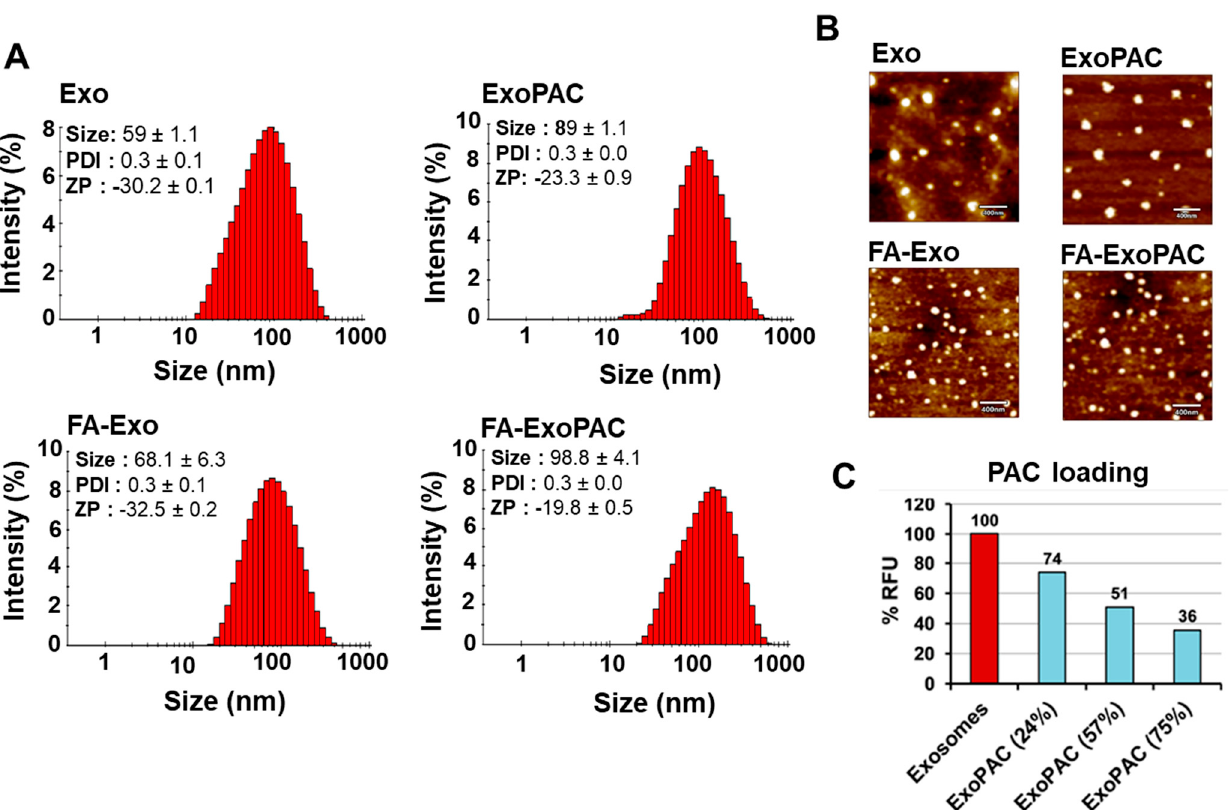
Figure 1. Characterization and drug loading of colostrum-derived exosomes. Size, polydispersity index (PDI), and zeta potential (ZP) of exosomes, FA-Exo, ExoPAC and FA-ExoPAC, analyzed by Zetasizer. Data represent mean ± SD from three preparations ( A ). Analysis of exosomes and ExoPAC by atomic force microscopy (AFM) after diluting with deionized water up to 10 µg/mL. For measurement, samples were placed on a silica wafer and air-dried for 30 min. AFM in tapping mode and aluminum-coated silicon probes were used for imaging ( B ). The bar diagram shows the quenching of autofluorescence from the exosomes following PAC loading ( C ). Higher quenching of fluorescence in the presence of higher drug load suggests a hydrophobic interaction of drug with exosomal proteins.